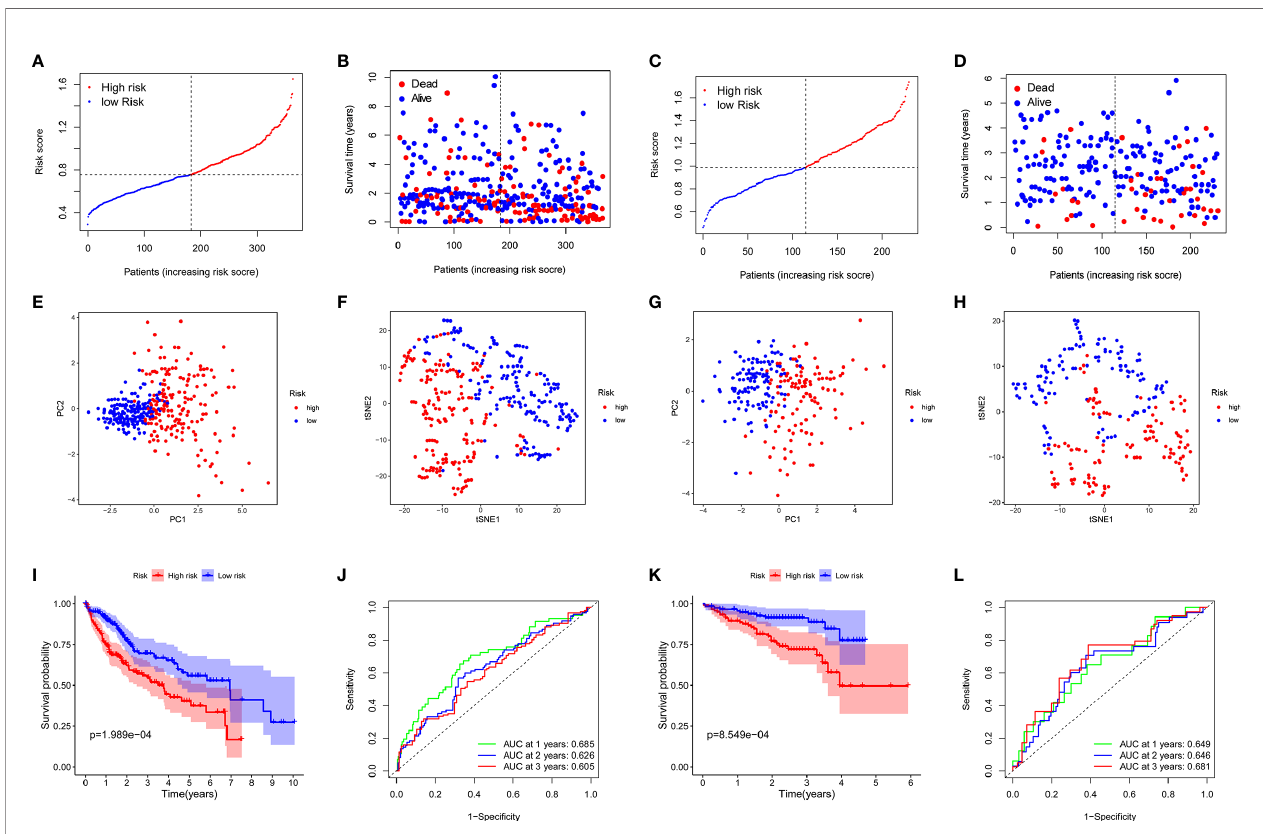
FIGURE 3 | Prognostic analysis of the 8-gene signature model in the TCGA cohort and ICGC cohort. TCGA cohort (A, B, E, F, I, J) , ICGC cohort (C, D, G, H, K, L) . (A, C) The median value and distribution of the risk scores. (B, D) The distribution of OS status. (E, G) PCA plot. (F, H) t-SNE analysis. (I, K) Kaplan-Meier curves for OS of patients in the high- and low-risk groups. (J, L) AUC time-dependent ROC curves for OS.